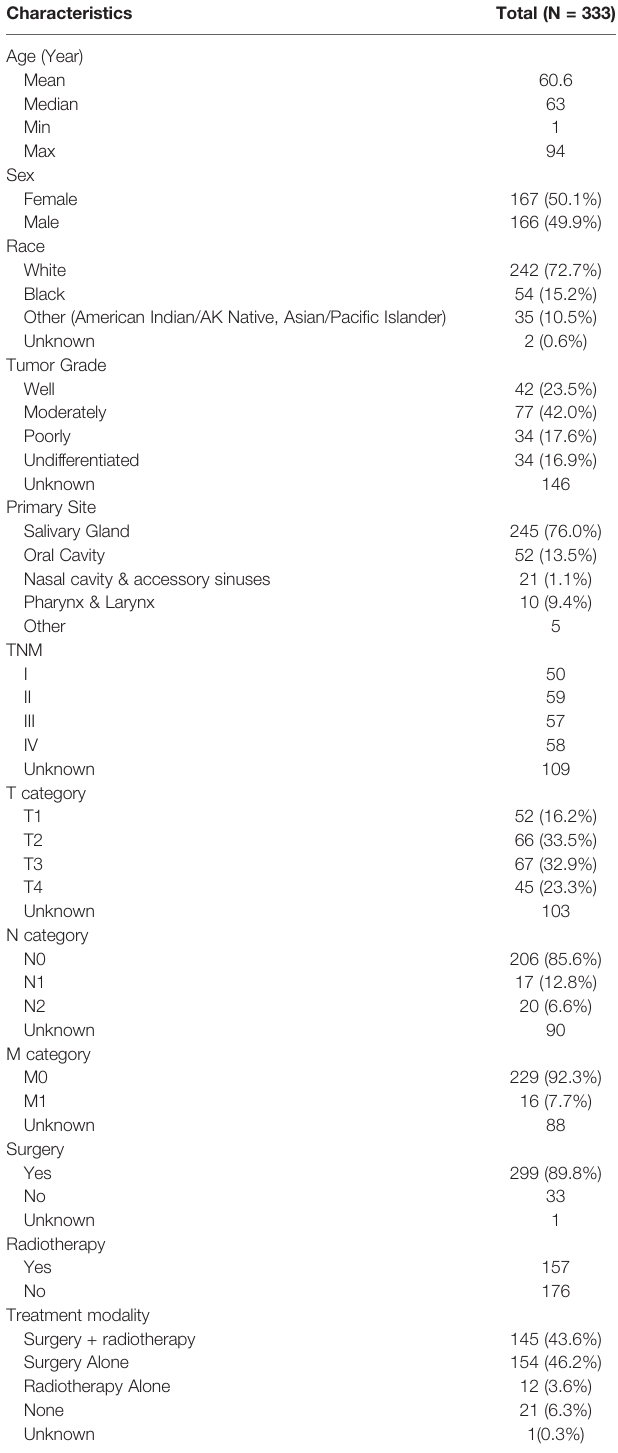
TABLE 1 | Patients ’